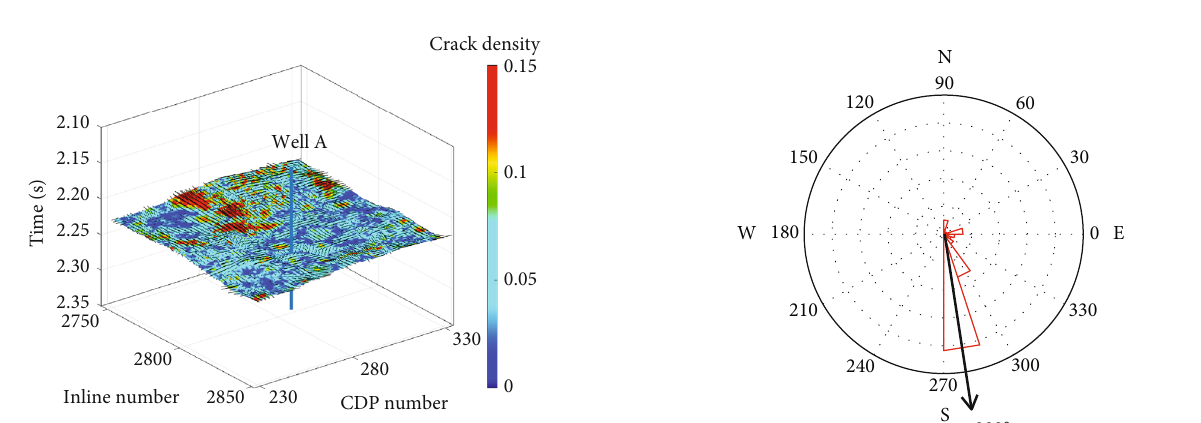
Figure 6: Four azimuthal seismic data with three angles of incidence (5 ° , 15 ° , and 25 ° ), where the average azimuth angles are 22.5 ° (a), 67.5 ° (b), 112.5 ° (c), and 157.5 ° (d).